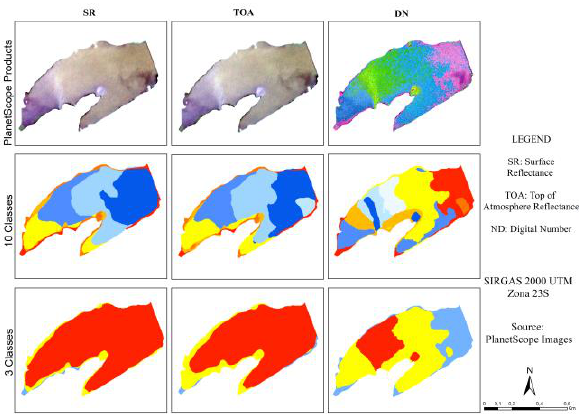
Figura 2 : PlanetScope Accumulated Products (SR, TOA and DN)